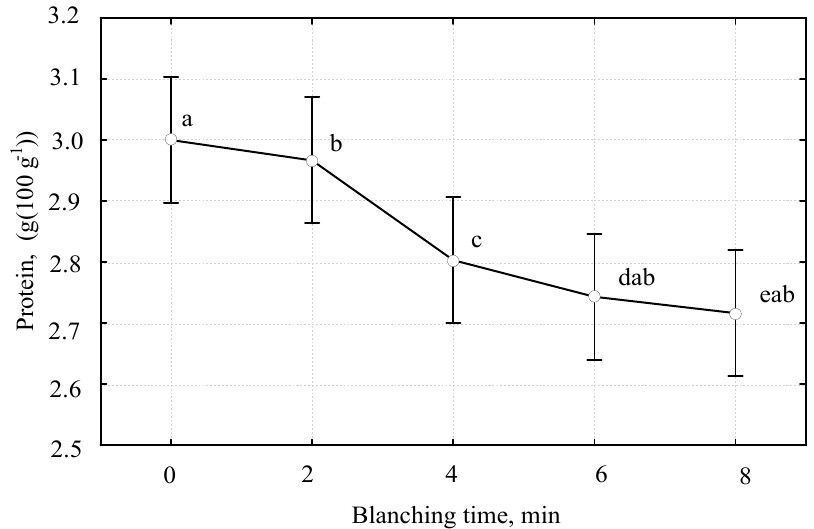
Figure 3. The influence of the blanching time on protein content including 95% confidence intervals. Means with the same letter are not significantly different from each other ( p < 0.05).